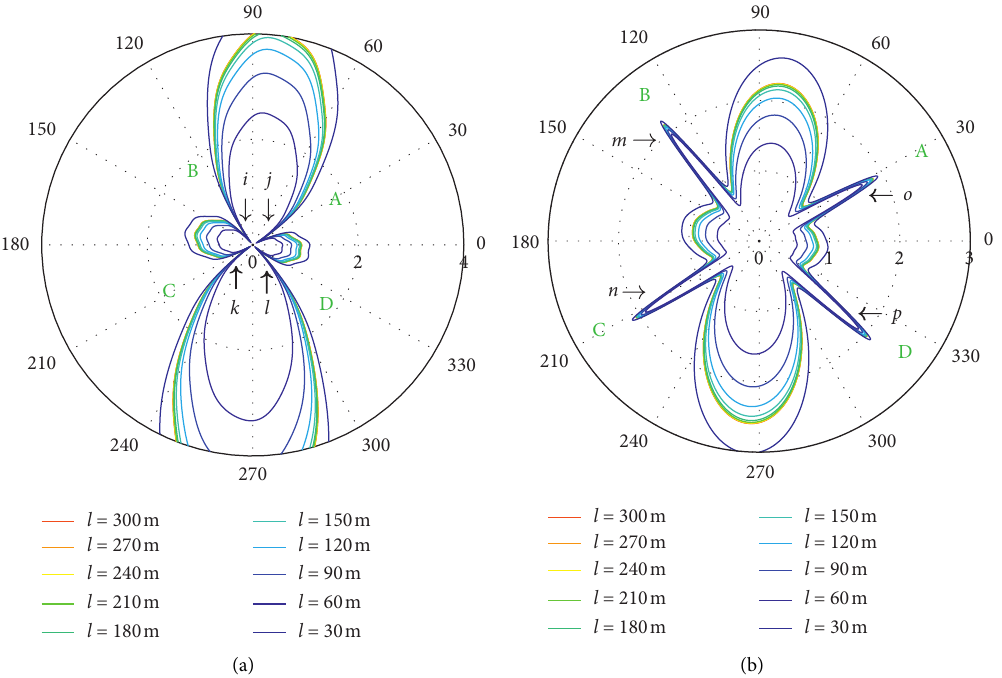
Figure 7: SRSI curve at the circumferential survey line of IRMR at different distances from the working face. (a) Surrounding rock surface. (b) Inner depth of surrounding rock 0.3m.